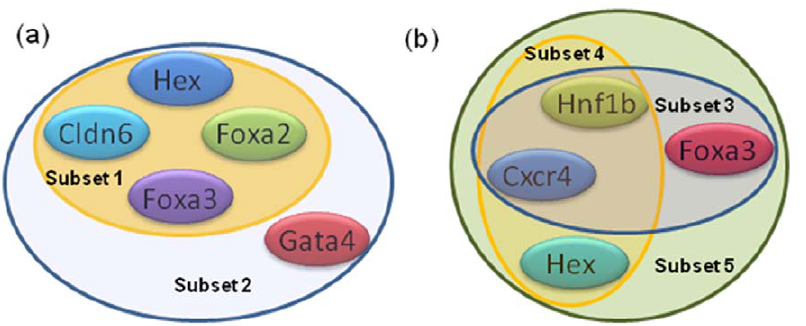
Figure 9. Robust subsets of co-regulated genes. Substets of co-regulated genes for 2-dimensional (a) and 3-dimensional (b) culture configuration. The 2D data set identifies two subsets while 3D data set identifies 3 subsets of regulatory interactions. respect to stem cell differentiation, isolation of Hex and Cxcr4 expressing cells from differentiating embryonic stem cells results in a population expressing anterior definitive endoderm markers.